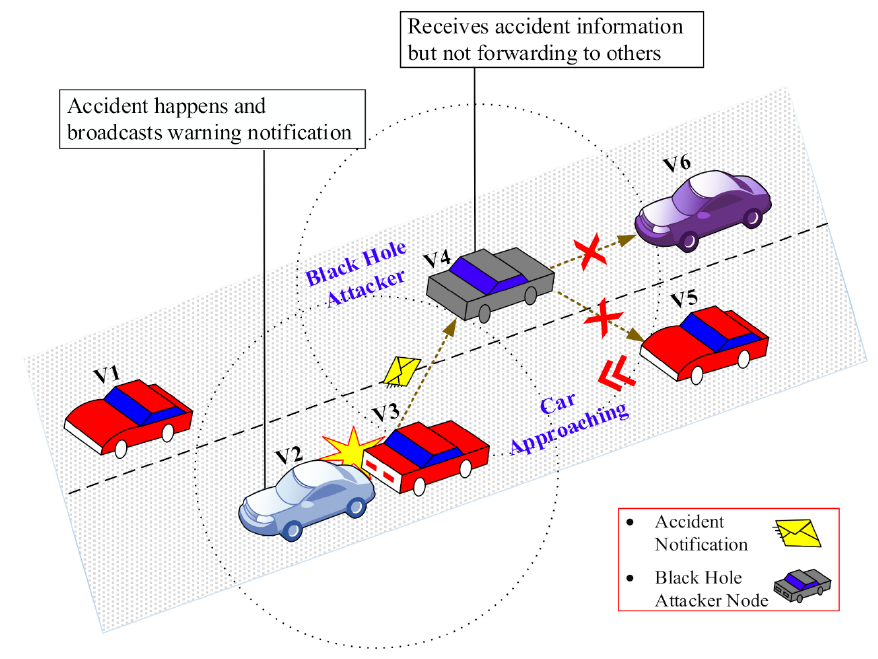
Figure 3. A visual representation of the impact of a BHA on